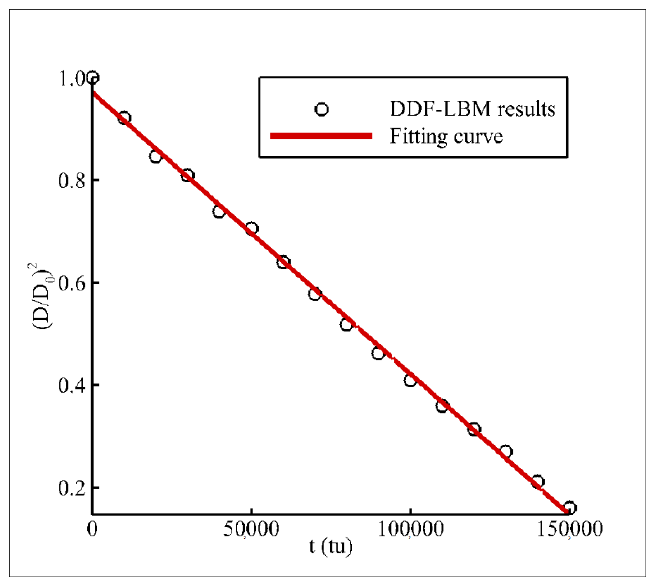
Figure 2. Validation of the D2 (the square of the droplet diameter) law by DDF–LBM model.